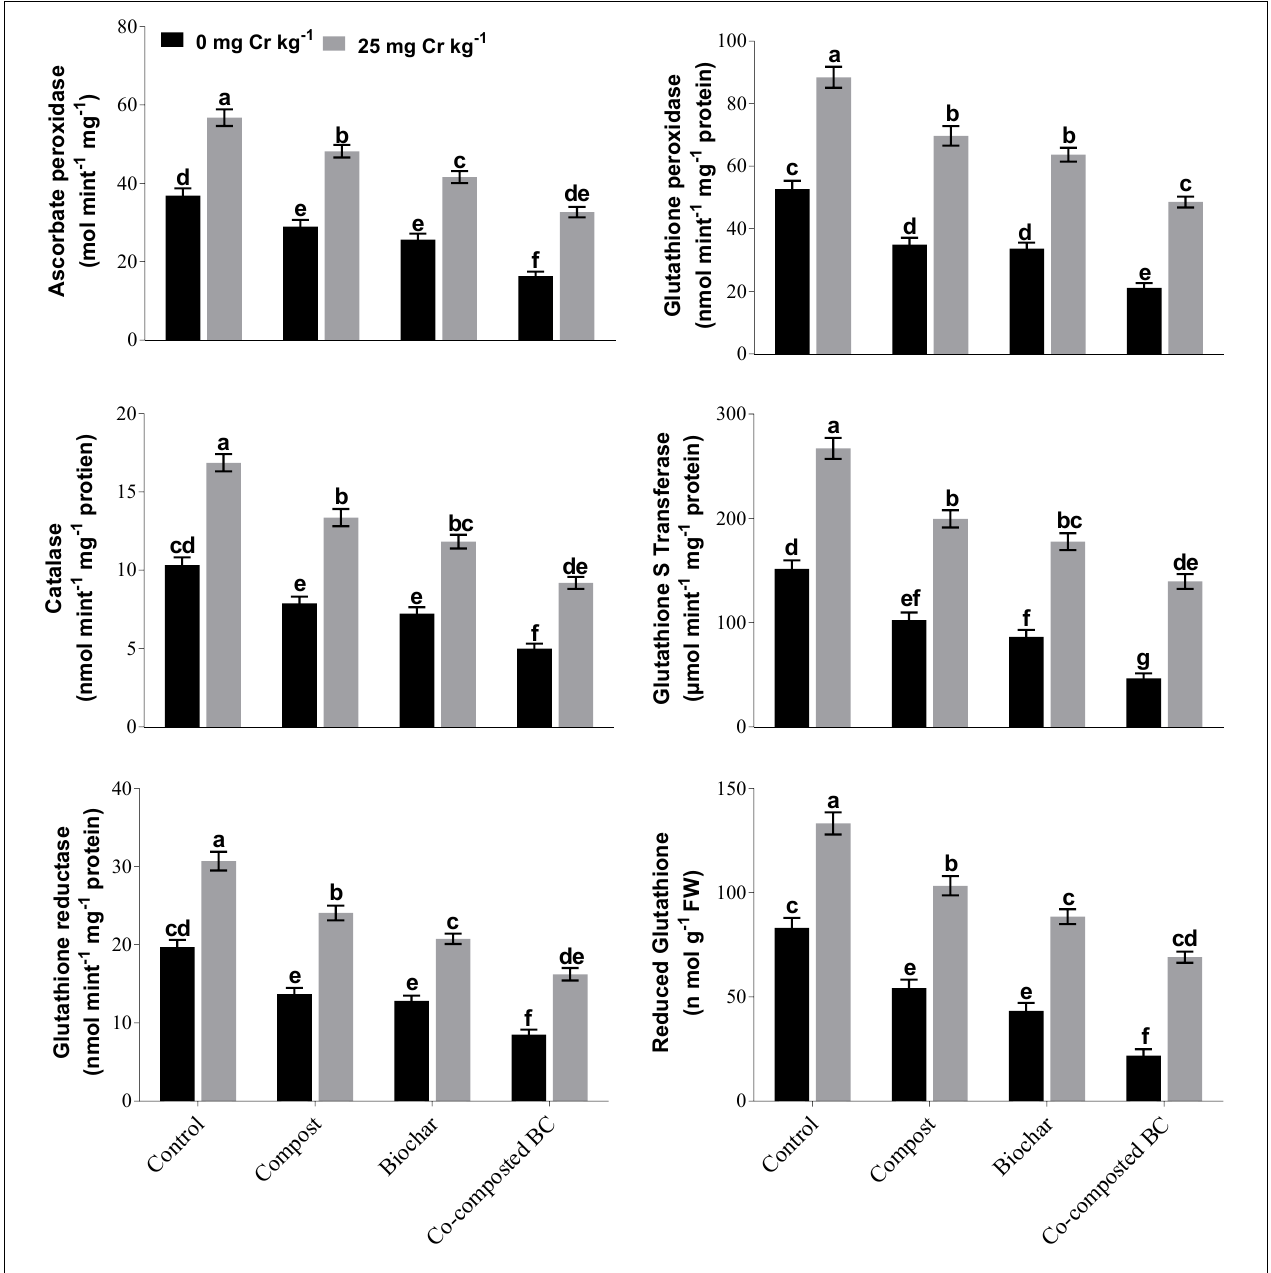
FIGURE 3 | Impact of compost, biochar, and co-composted biochar on antioxidant activities of Brassica . The values are presented as mean ± standard error ( n = 3). The values sharing the same letter(s) in bars are statistically non-significant with each other at p < 0.05.